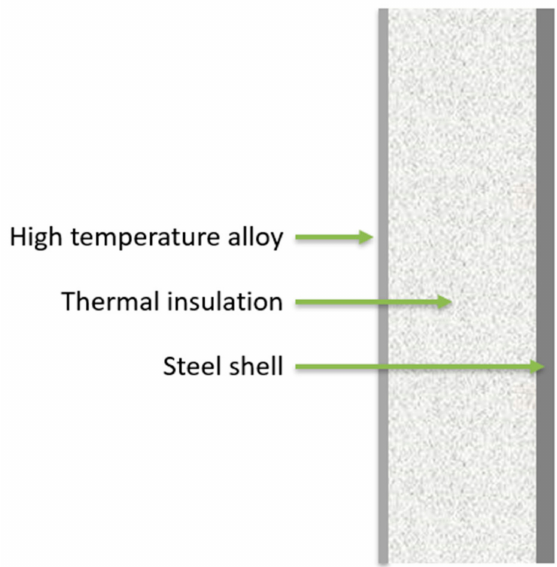
Figure 5. Assumed reactor wall